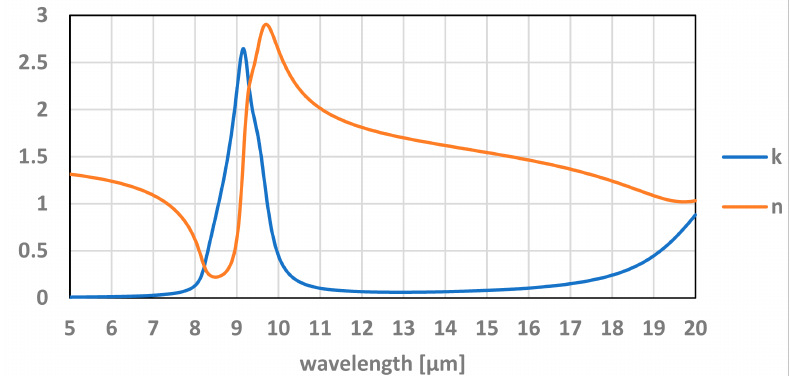
Figure 16. The refractive index of SiO 2 as a function of the TMOS bandpass wavelength where ( n ) is the real part and ( k ) is the imaginary